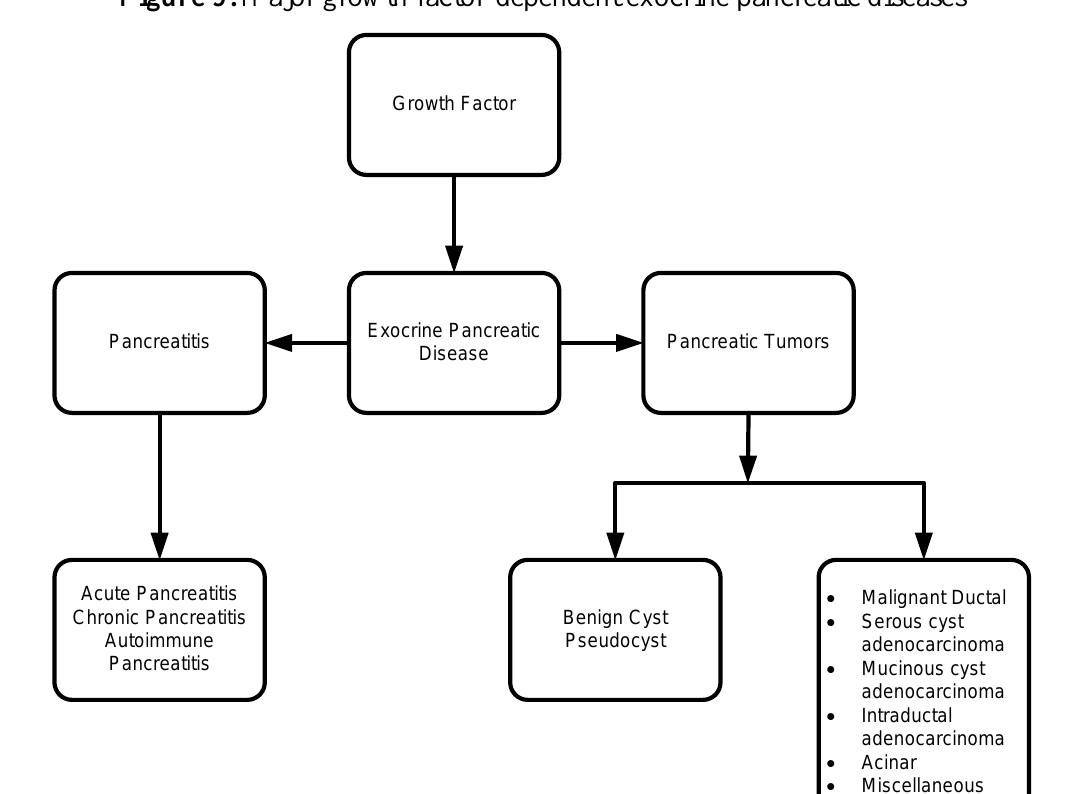
Figure 9. Major growth factor-dependent exocrine pancreatic